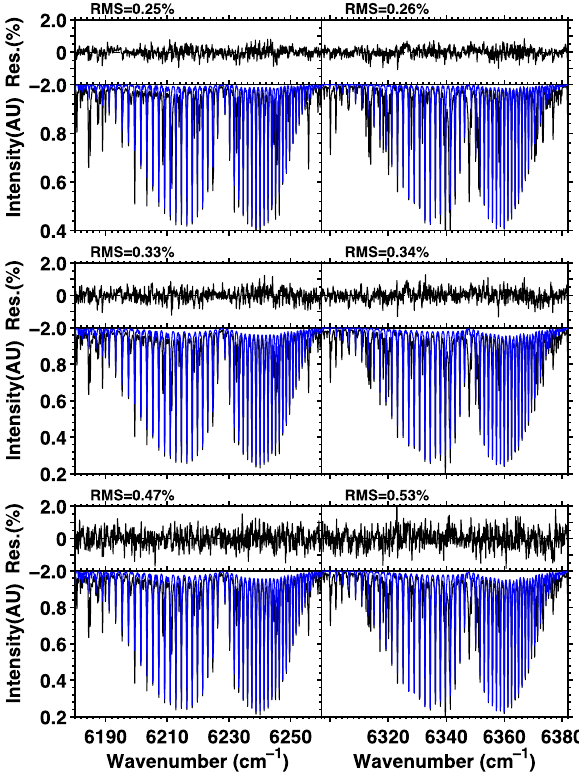
Figure 4 . Sample spectral fittings of CO 2 bands near 1.6 m region using the CLARS-FTS measurements in the Spectralon viewing geometry (top panels); pointing at the Santa Anita Race Track, Arcadia (middle panels); or pointing at the west Pasadena (bottom panels). The measurements were taken on January 3 rd , 2013 with a Solar Zenith Angle (SZA) of 58.62º (top panels), 58.39º (middle panels), and 57.89º (bottom panels) respectively. Each spectrum is from 12 co-added scans, which were taken consecutively over 3 minutes. The spectral SNR are 532:1, 417:1, and 227:1 from top to bottom panels, respectively. The measured radiances subtracting the simulated spectra, which included contributions of all trace gases and solar lines, yield the spectral fitting residuals. In all panels, black curves are measured spectra and blue curves are the estimated contribution of CO 2 absorption from the spectral fittings. Contributions of other species in these spectral regions are not shown.